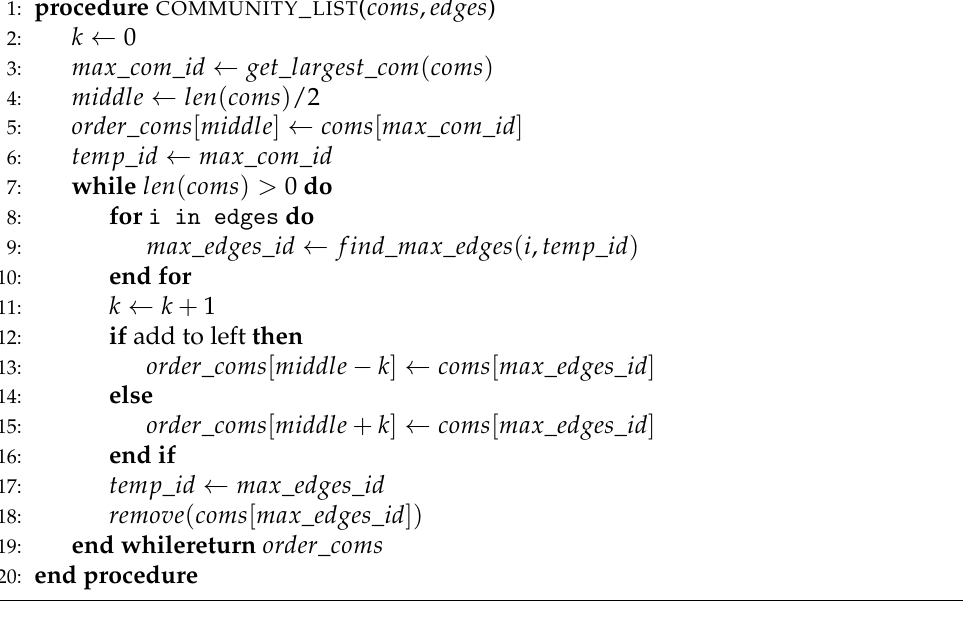
ties with most interactions are closest.